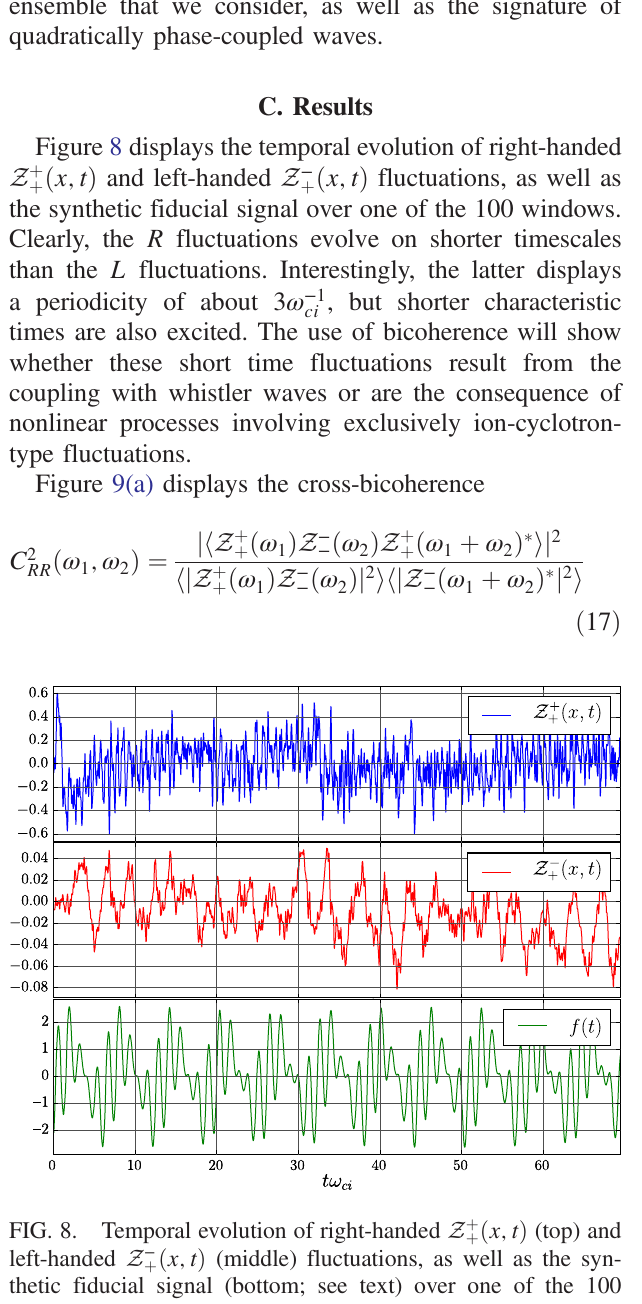
ð x; t Þ (top) and þ